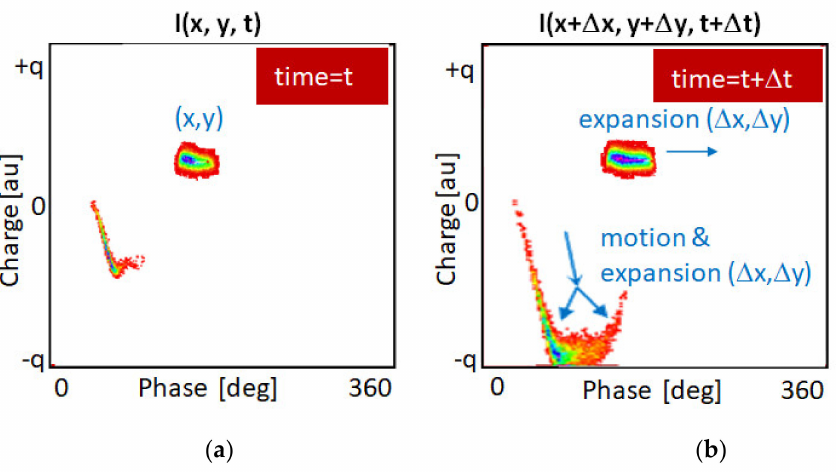
Figure 14. Visualization of PD pattern evolution in a form of motion and expansion along phase and charge axes: ( a ) image at time t; ( b ) image at time t + ∆